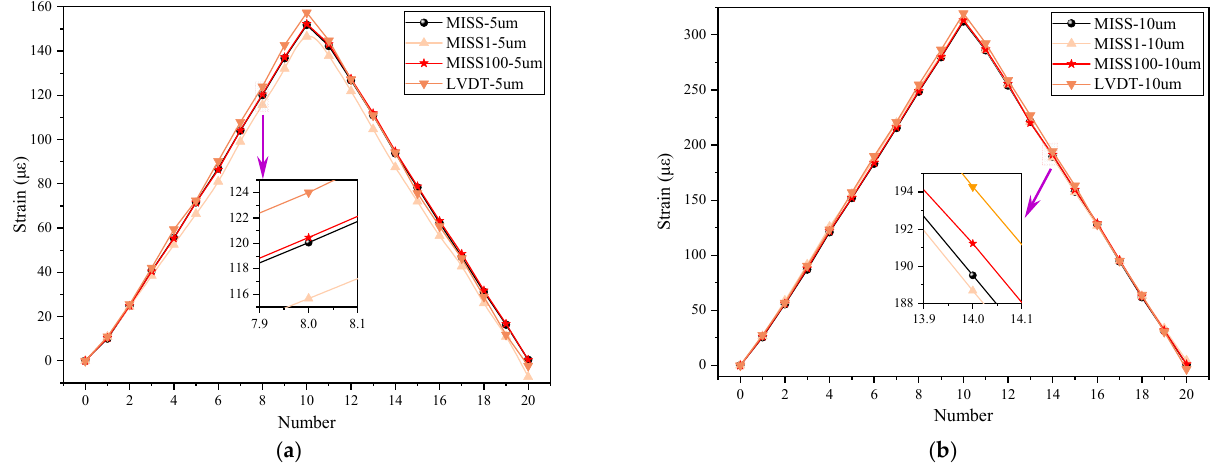
Figure 5. Comparison results of the static tests. ( a ) Comparative results for a movement of 5 μ m; ( b ) comparative results for a movement of 10 μ m.